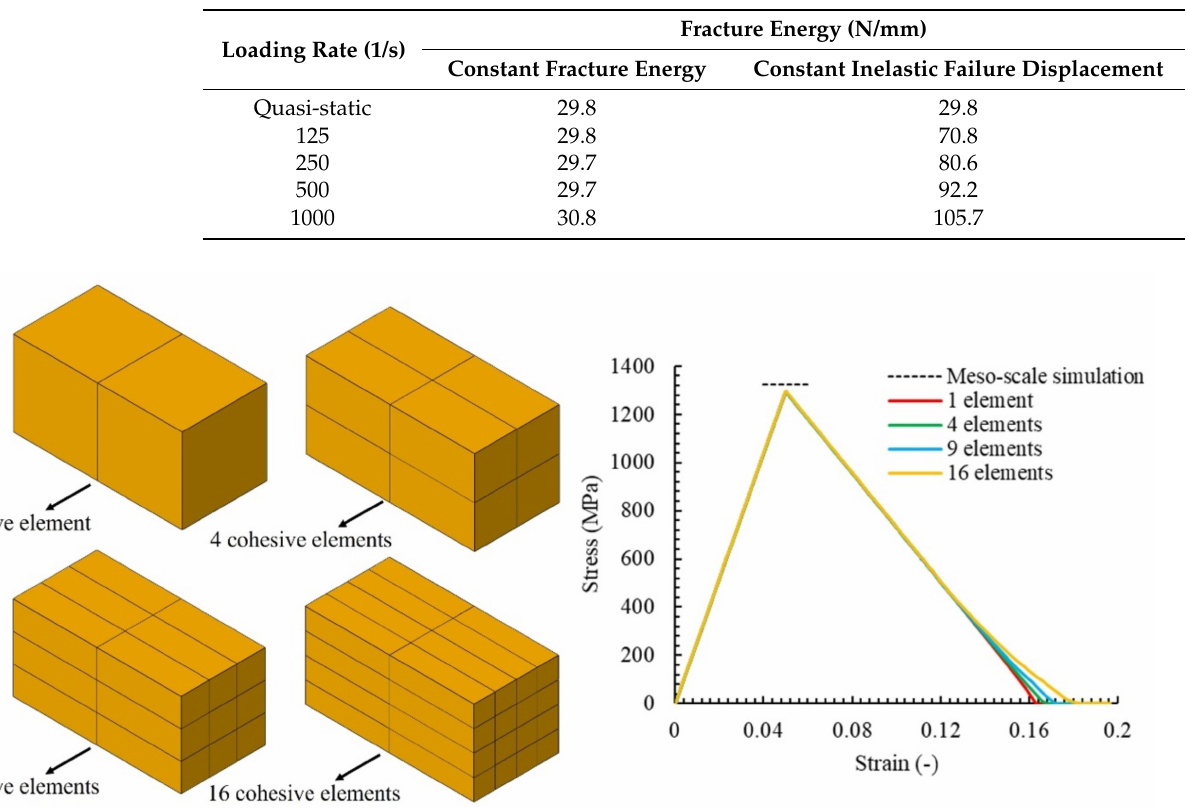
Table 2. Fracture energy predictions from the two cohesive zone methods for different loading rates.